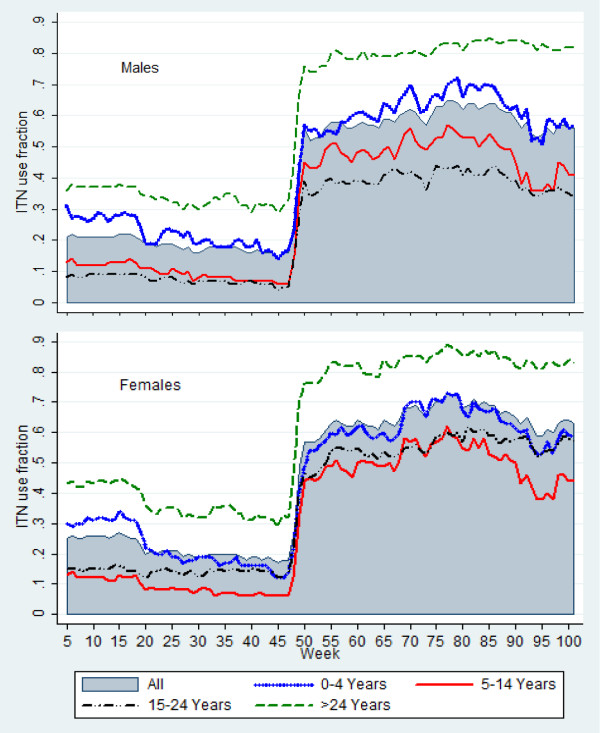
Insecticide-treated bed net use fraction by gender and age group.